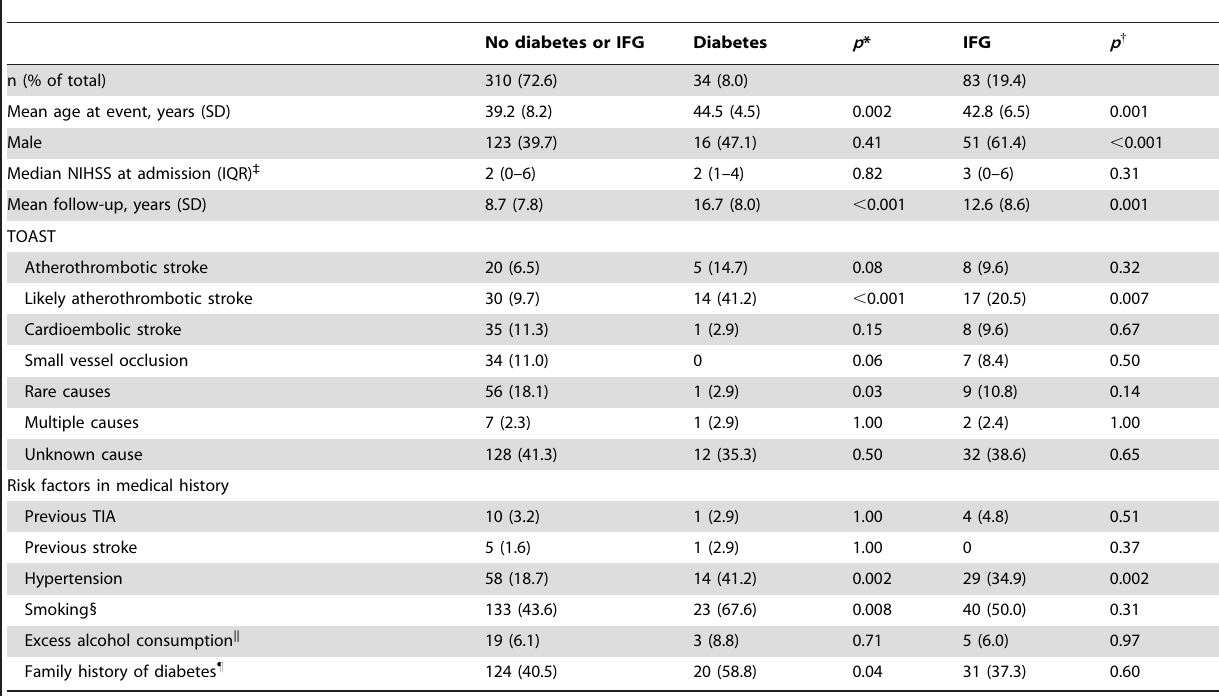
Table 2. Presence of baseline factors in patients with incident diabetes or impaired fasting glucose at